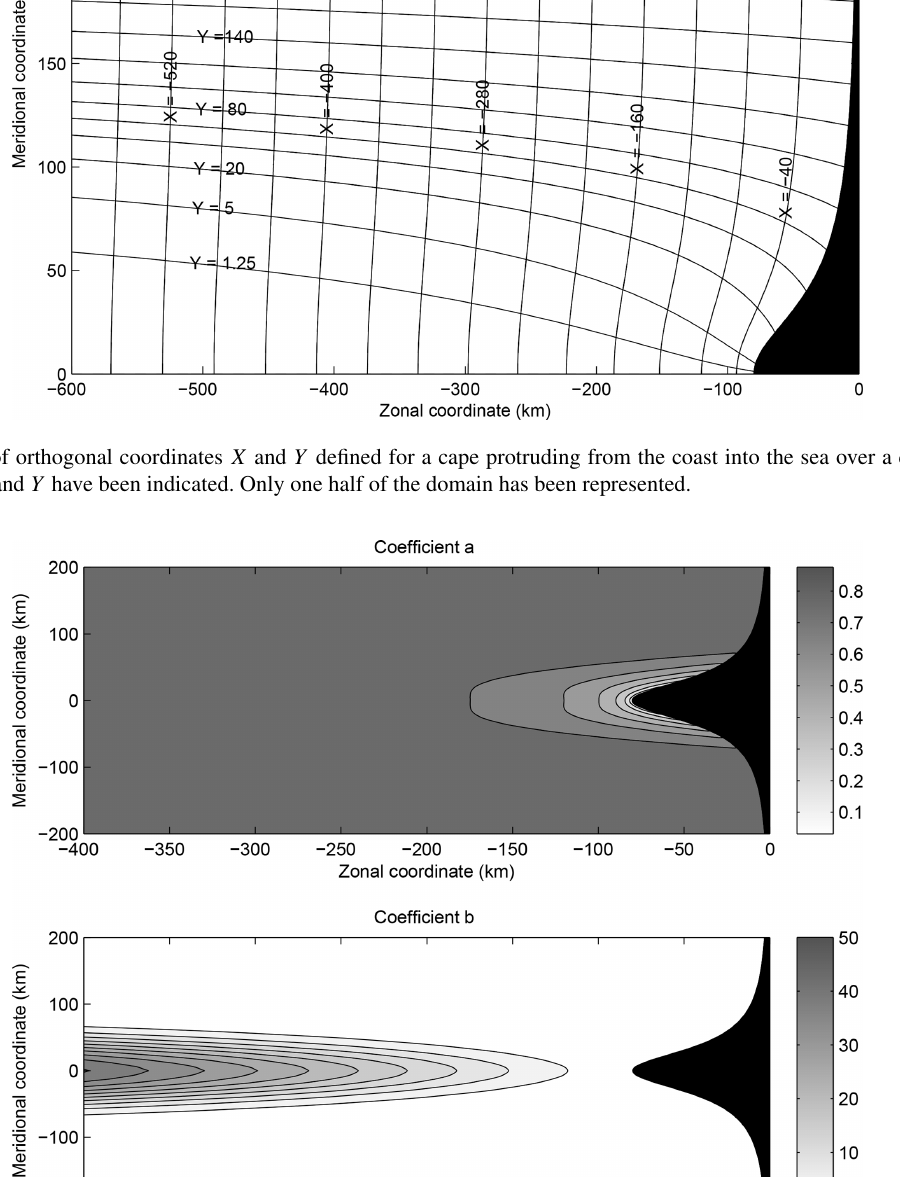
Ocean Sci., 15, 1667–1690, 2019